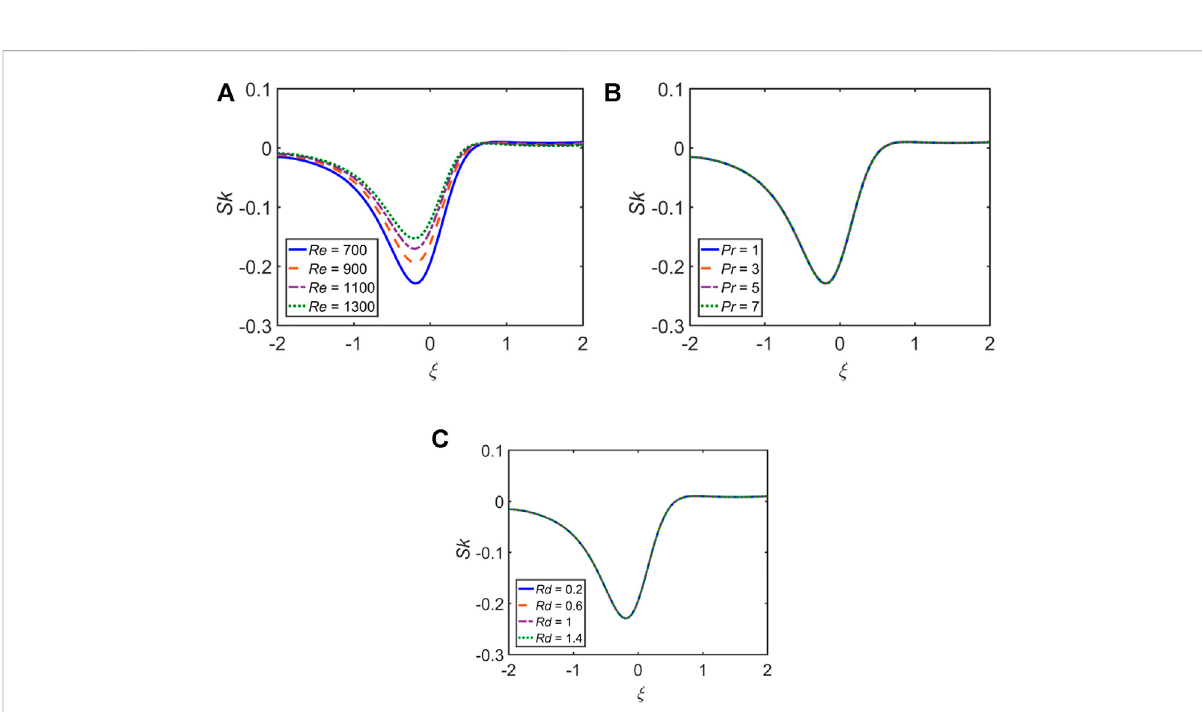
Impact of (A) Re , (B) Pr , and (C) Rd on Sk